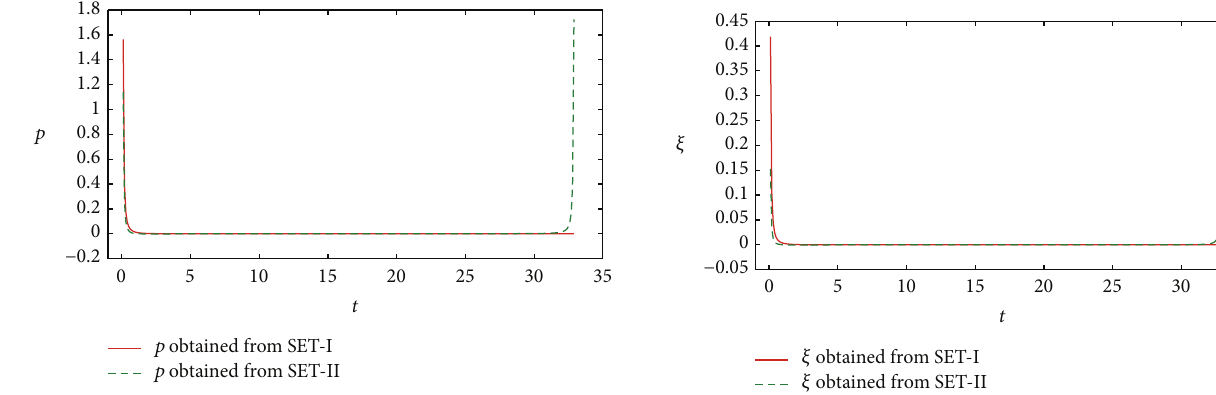
Figure 4: Coefficient of bulk viscosity 𝜉 versus time 𝑡 for 𝜇 = 0 . 5, = 1 / 3, 𝛾 = 1 / 4, 𝛽 = 1 . 5, 𝛼 = 0 . 1, 𝐴 𝜖 0 𝑘 = 0 .